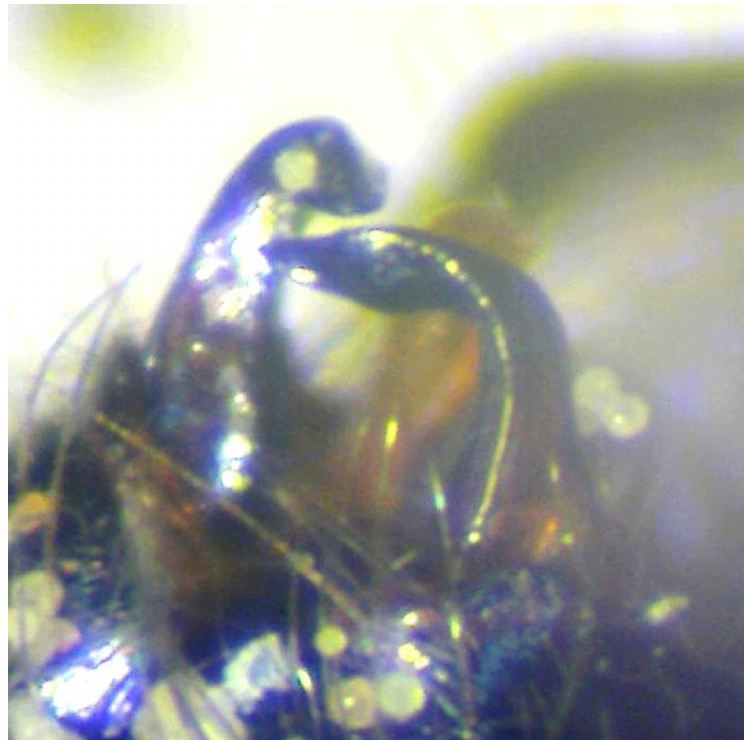
Fig. 22. Parusia aurata (Fabricius, 1794) gen. et comb. nov.,